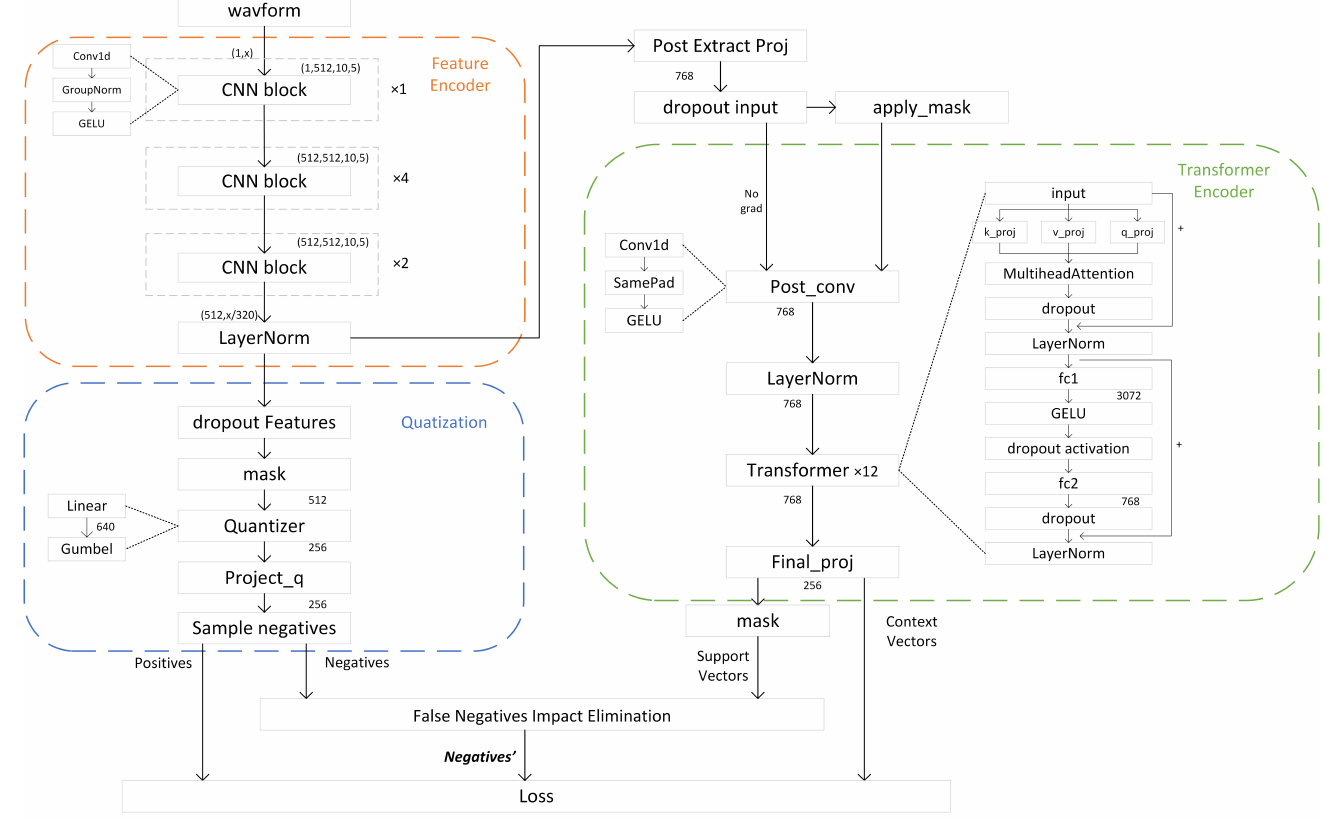
Figure 7. Illustration of the overall network structure of our experimental